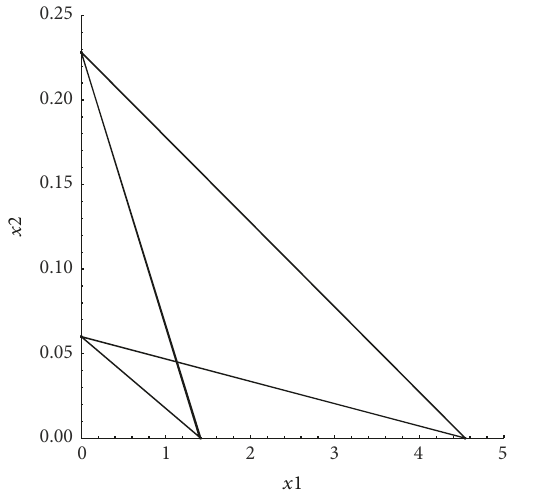
Figure 2: 4-periodic SYC dynamics. (𝛼,𝛽) = (1,0.8) and (𝑃,𝐹) = (0.5, 25)